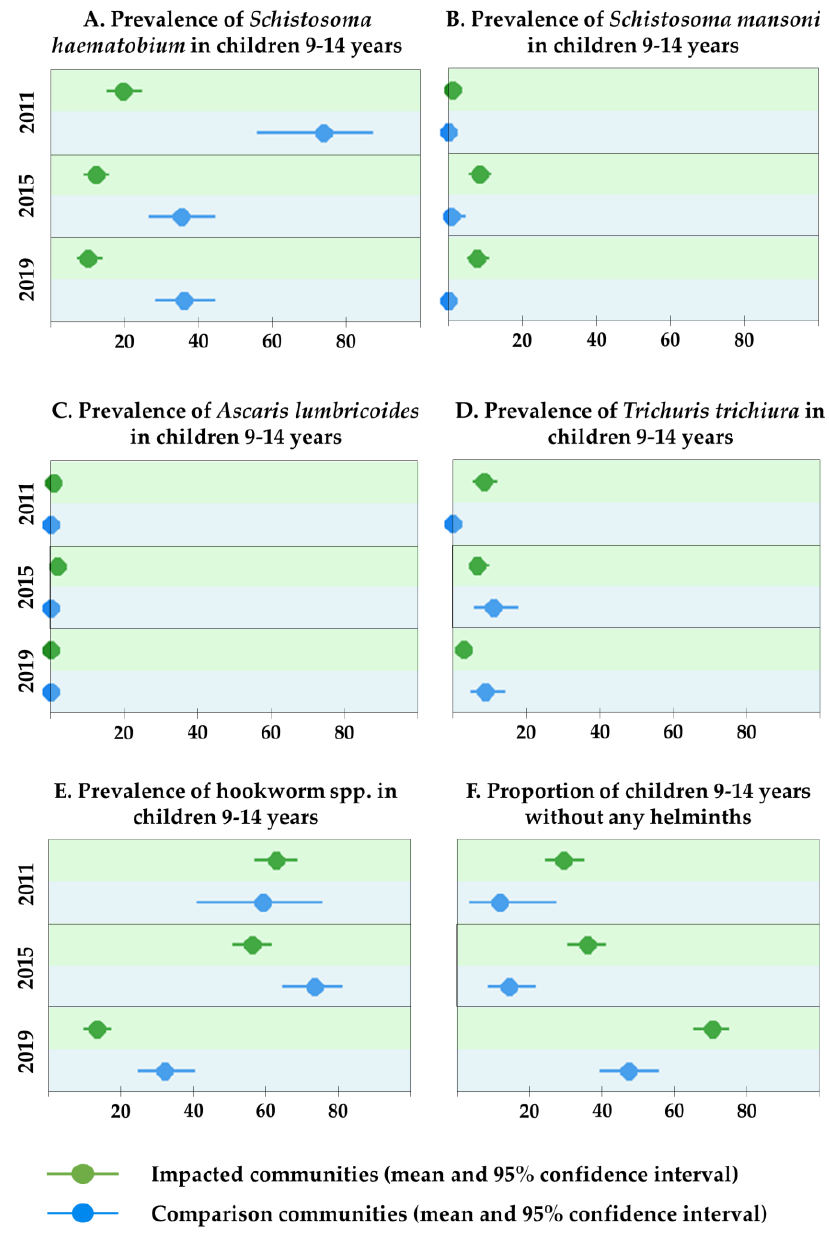
Figure 4. Schistosomiasis and soil-transmitted helminth indicators, Trident project, Zambia (2011, 2015 and 2019).